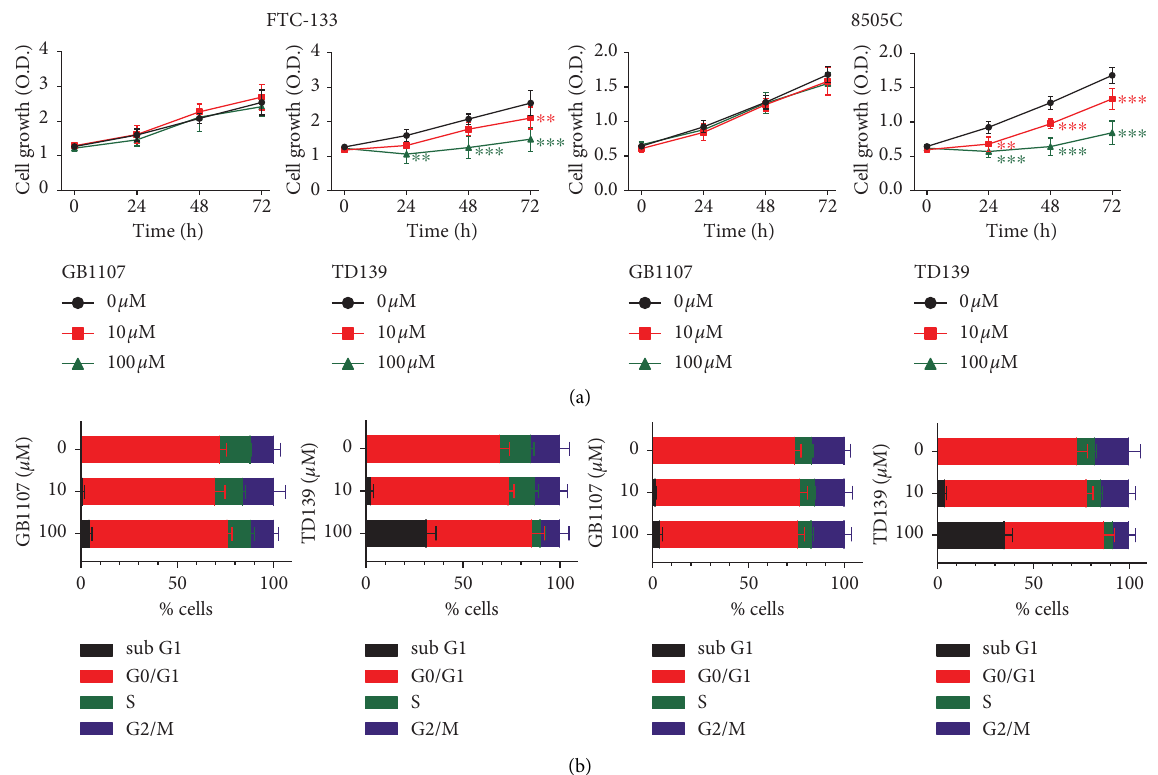
Figure 1: Effects of galectin-3 inhibitors (GB1107 and TD139) on cell growth and cell cycle distribution in FTC-133 and 8505C human thyroid cancer cells. (a) Cells were treated with GB1107 or TD139 of the indicated concentrations for 24 to 72 hours, and cell viability was determined using Cell Counting Kit-8 assay. O D., optical density value at 450nm. (b) The distribution of cell cycle following treatment with GB1107 or TD139 for 24 h was determined using flow cytometry. ∗∗ p < 0 . 01, ∗∗∗ p < 0 .